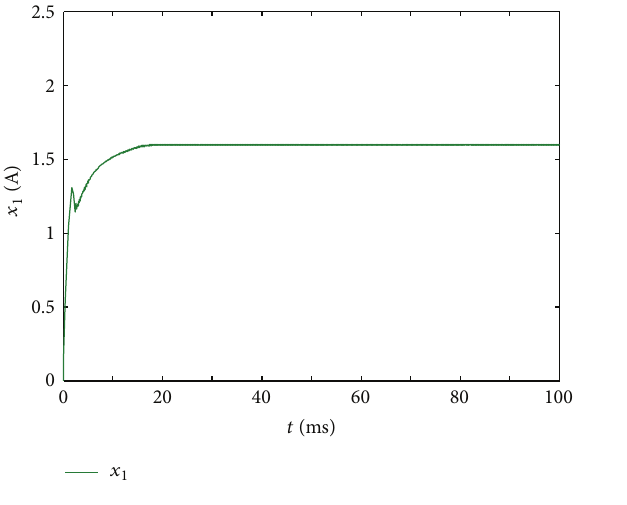
Figure 4: Response of output voltage in steady